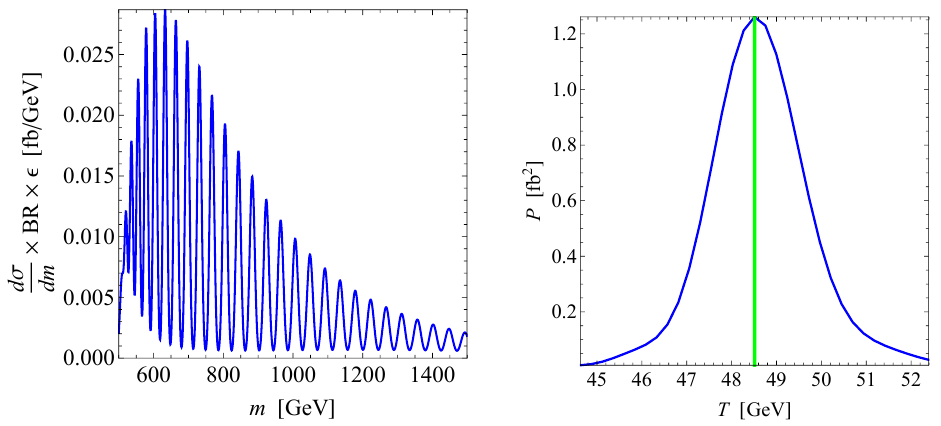
Figure 14 . The diphoton mass spectrum for M 5 = 6 TeV, k = 500 GeV in the range k < m < 3 k (left) and its power spectrum obtained from eq. (3.5) (right). The expected periodicity, 1 =R , is indicated by the green vertical line.